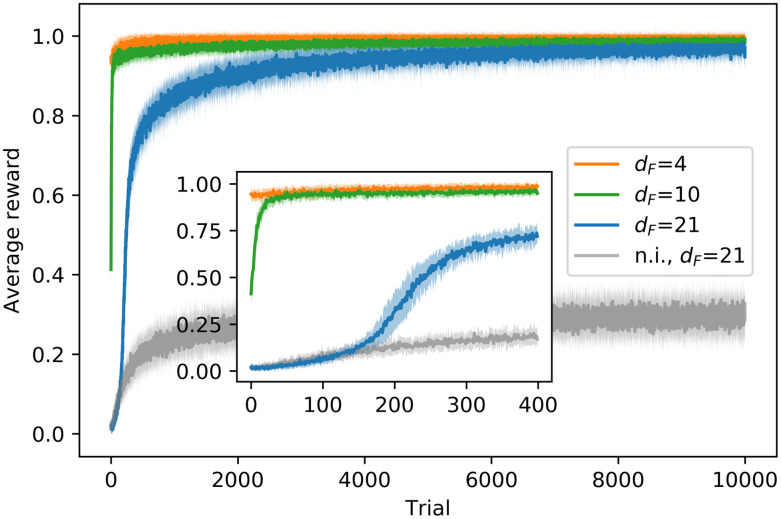
Learning curves for dF = 4, 10, 21 and dF = 21 for non-interacting (n.i.) agents.The curve shows the percentage of agents that reach the food source and obtain a reward of R = 1 at each trial. For each task, the average is taken over 20 (independent) ensembles of 60 agents each and the shaded area indicates the standard deviation. Zooming into the initial phase of the learning process, the inset figure shows a faster learning in the task with dF = 10 than in the task with dF = 21. In the case of dF = 21, no agent is able to reach the food source in the first trial, and it takes the interacting agents approx. 200 trials to outperform the n.i. agents.